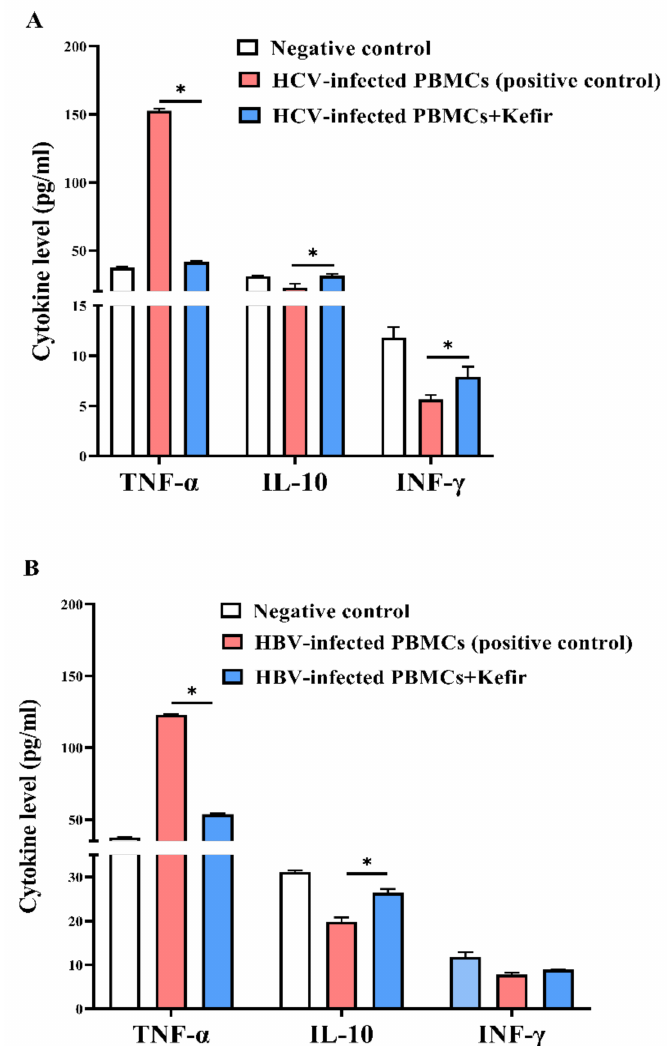
Figure 8. Cytokine levels (pg./mL) of TNF- α , IL-10, and INF- γ after treatment of infected PBMCs with kefir extract in comparison with negative and positive controls. ( A ) HCV and ( B ) HBV. All data are demonstrated as mean ± SEM. The data mean is considered significantly different at p ≤ 0.05 and is marked as